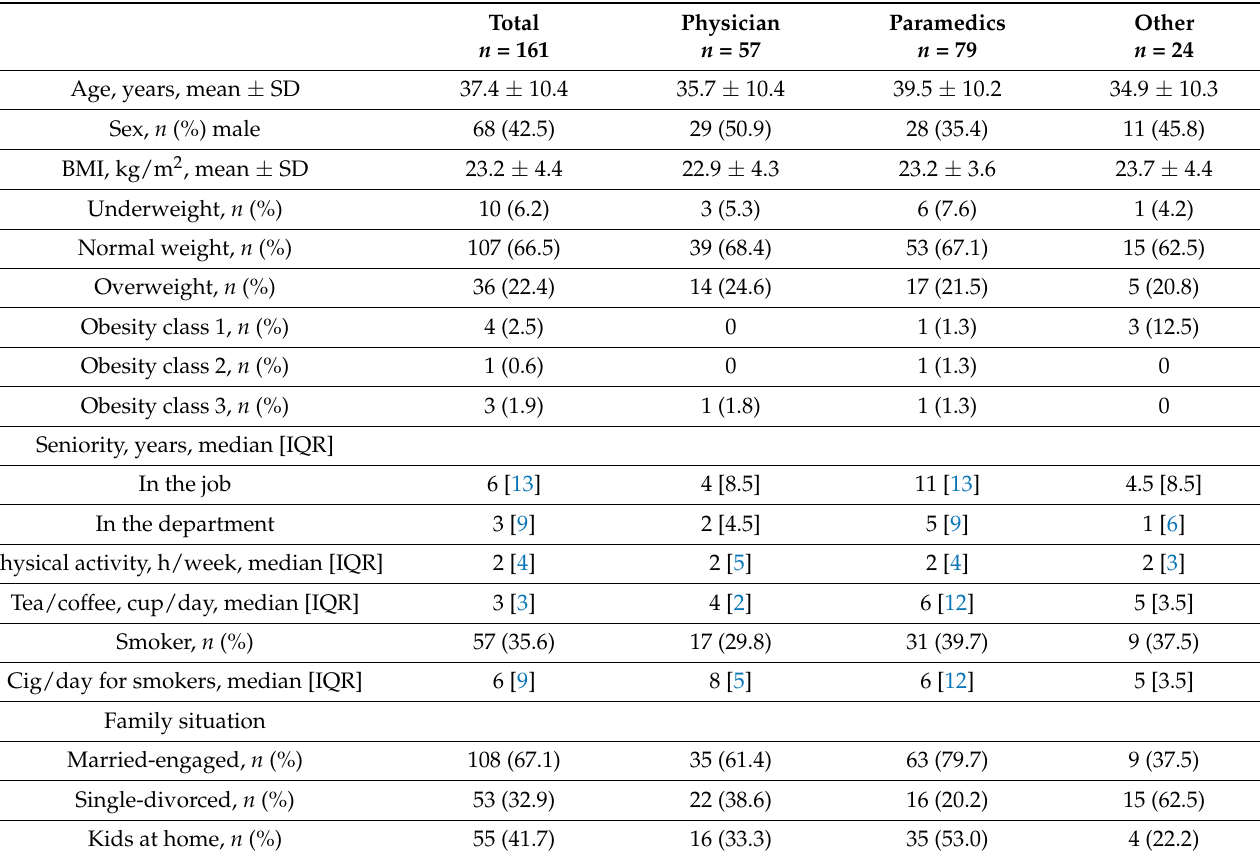
Table 1. Sociodemographic. SD = standard deviation, BMI = body mass index, kg = kilograms, kg/m 2 = kilogram per square meter, IQR = interquartile range, n = number, % = percentage. Results are expressed as mean ± standard deviation or median [interquartile range] or number (percentage). Total n =